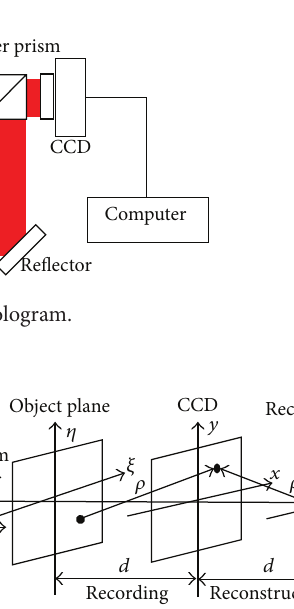
Figure 2: Coordinate system for image